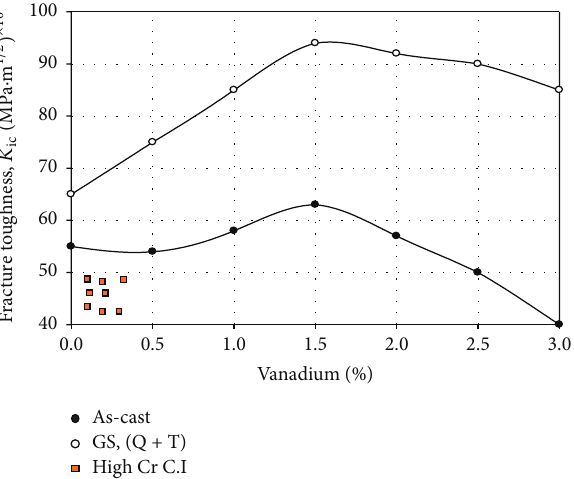
Figure 10: Influence of vanadium on fracture toughness coefficient as measured for GS alloys in comparison with 25% Cr cast iron.